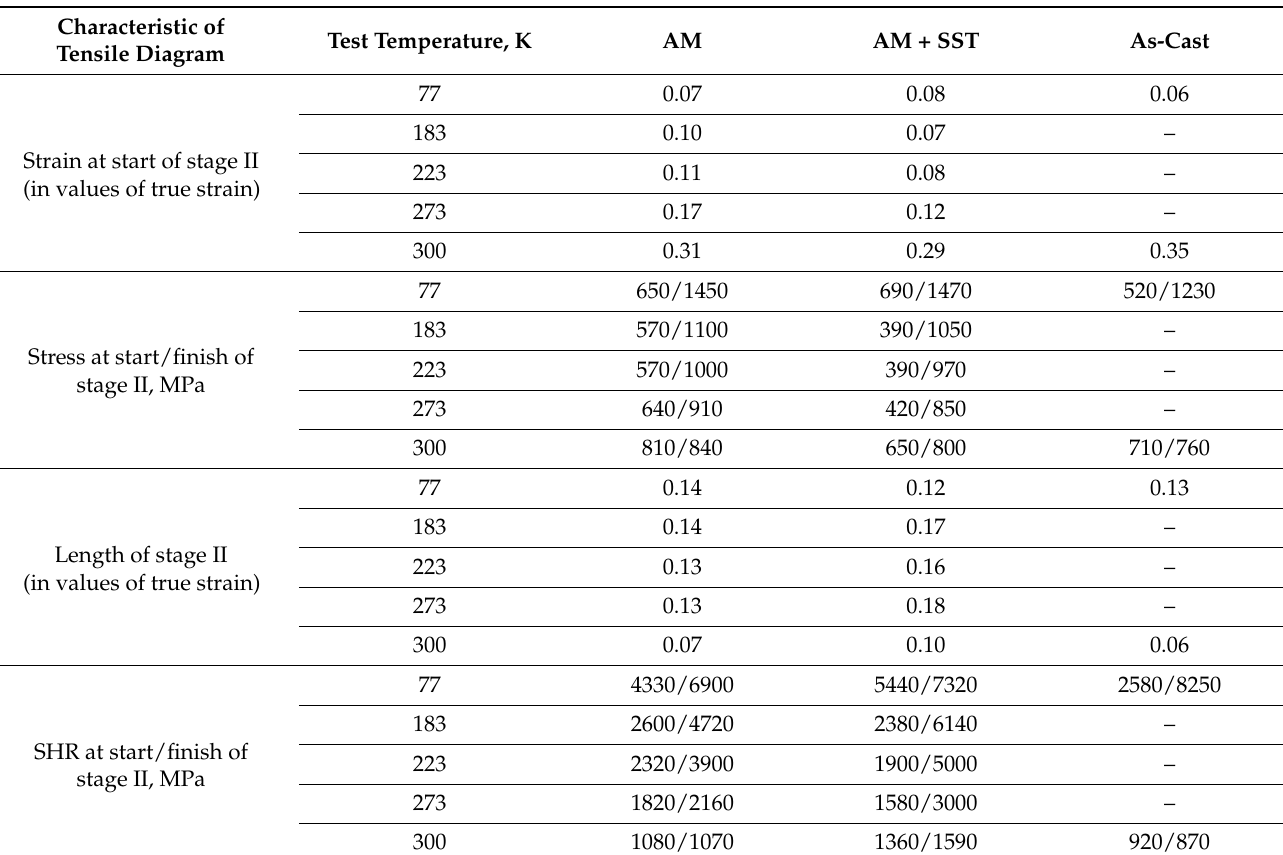
Table 1. The characteristics of the stage II of the plastic flow for the AM, AM + SST and the as- cast